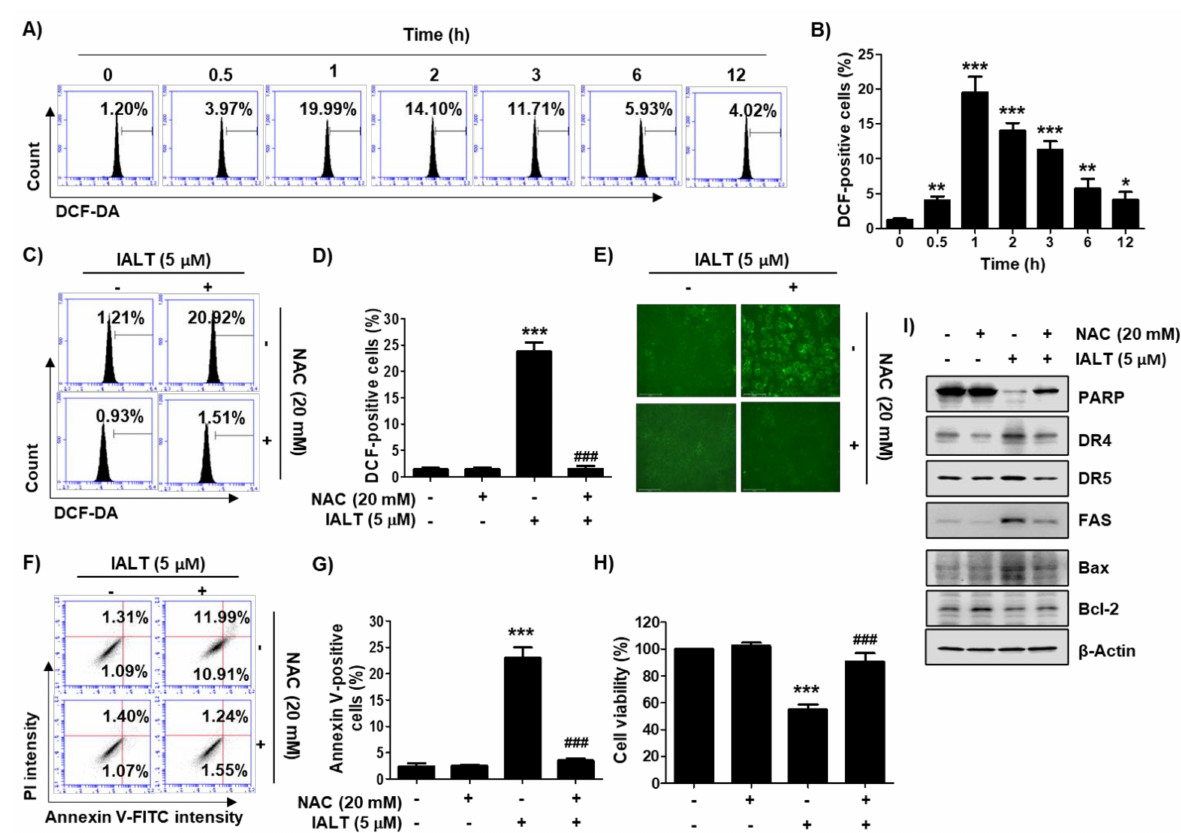
Figure 3. An increase in reactive oxygen species (ROS) production by IALT and its role on IALT-induced cytotoxicity in Hep3B cells. ( A – E ) Cells were treated with 5 µ M IALT for the indicated times ( A , B ), or treated with or without 20 mM NAC for 1 h, and then treated with 5 µ M IALT for 1 h ( C – E ). After staining with 2’,7’-dichlorofluorescein-diacetate (DCF-DA), ROS production was measured by flow cytometry analysis. ( A , C ) Representative profiles of flow cytometry results are presented. ( B , D ) The frequency of DCF-positive cells was expressed. ( E ) ROS generation was detected by a fluorescence microscope, and representative fluorescence micrographs depicting ROS generation are presented. ( F – I ) Cells were treated with 5 µ M IALT for 48 h with or without 20 mM N-acetyl-L-cysteine (NAC) for 1 h. ( F , G ) Quantitative analysis of apoptosis induction by annexin V and PI staining was performed. ( F ) Representative profiles of flow cytometry results are presented. ( G ) The percentage of apoptotic cells was expressed as a percentage of the total number of annexin V-positive cells. ( H ) Cell viability was measured by the MTT assay. ( B , D , G , H ) Data are expressed as the mean ± SD (* p < 0.05, ** p < 0.01 and *** p < 0.001 compared to untreated cells. ### p < 0.001 compared to 5 µ M IALT-treated cells). ( I ) The results of Western blot analysis of the indicated proteins are presented. β -actin was used as the loading